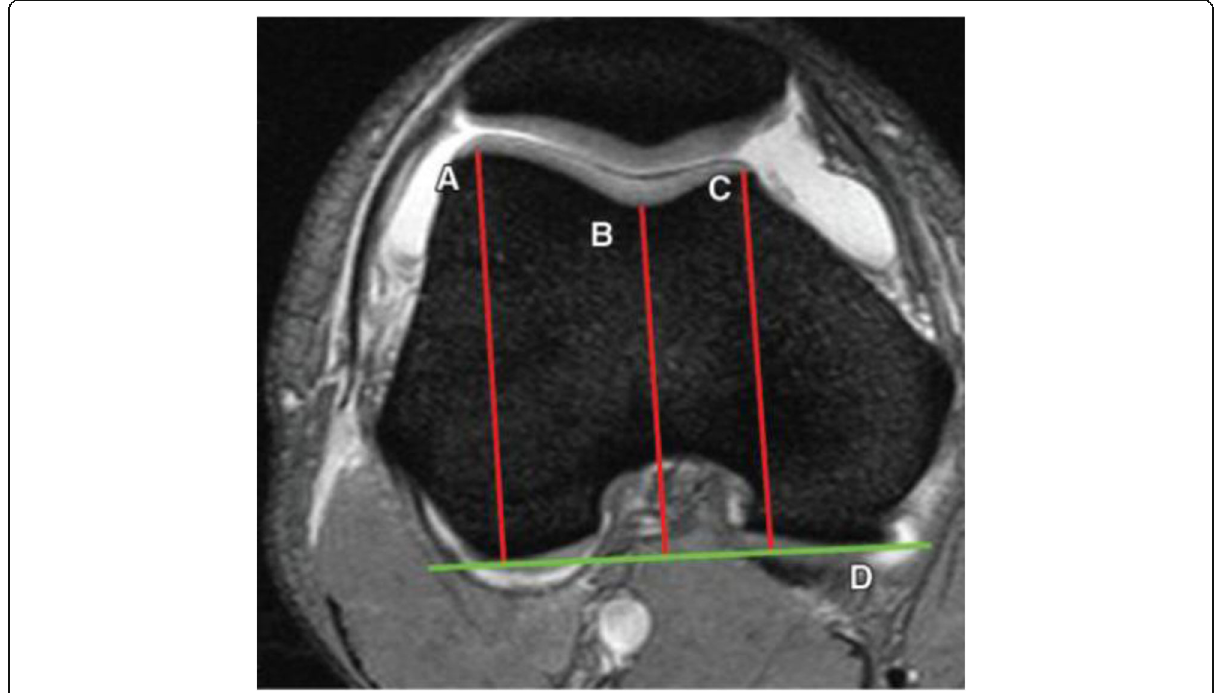
Fig. 4 Axial fat-saturated T2-weighted MR image for assessment of the trochlear; a line was drawn tangential to the posterior aspect of the femoral condyles and was considered as a reference line (line D ). The lines were drawn perpendicularly to the (line D ) and indicated the longest anteroposterior diameters of the lateral (line A ) and medial (line C ) trochlear facets and the deepest point of the trochlear groove (line B ). The femoral trochlear depth was calculated as (A + C/2) – B. A trochlear depth of 3mm or less was considered as an indicator of trochlear dysplasia [9]